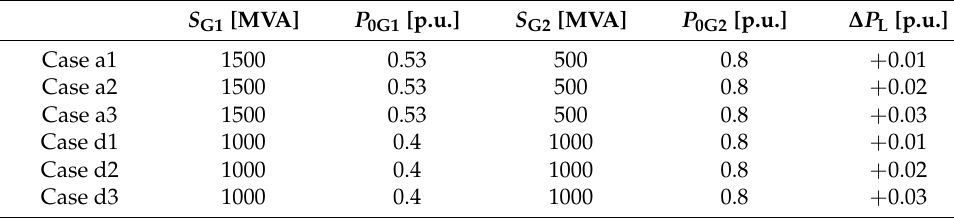
Table 6. Simulation parameters of the load fluctuation with the limiter control system.